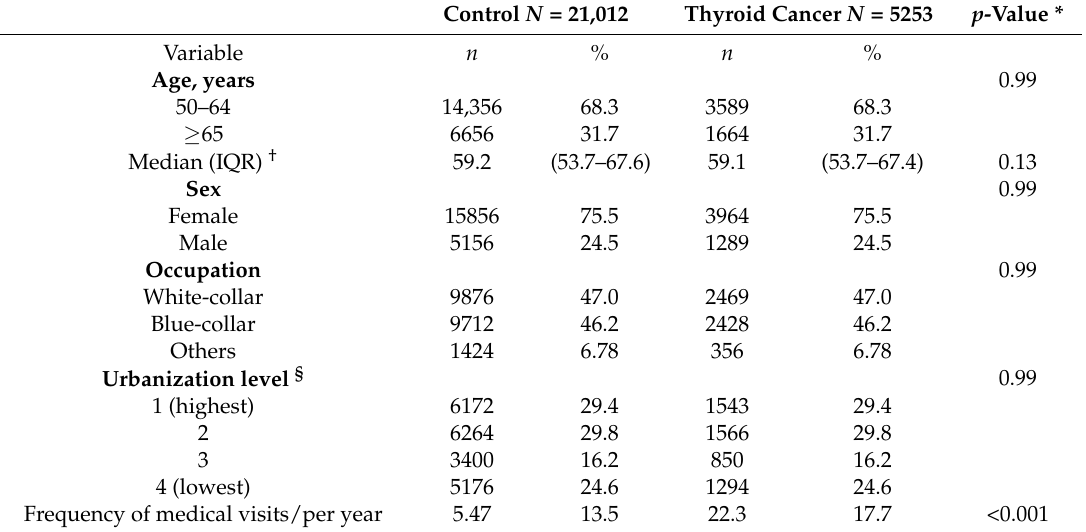
Table 1. Demographic factors and comorbidities of the study participants according to their thyroid cancer